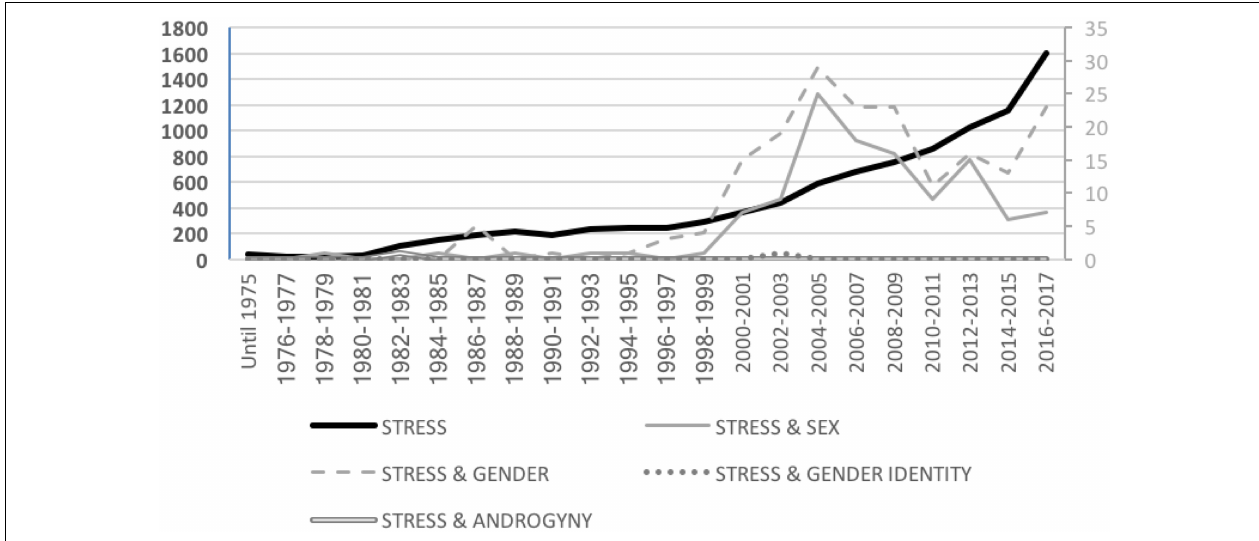
FIGURE 2 | Total number of scientific articles per year about workplace stress by gender category. Given the substantially greater number of studies examining workplace stress than studies incorporating a gender perspective, data are presented in different scales. The axis on the left side of the figure represents the total number of articles for workplace stress (without gender-related keywords), whereas the axis on the right represents the total number of articles incorporating a gender perspective in any of our four gender categories (i.e., gender, sex differences, gender identity, or androgyny). The same rationale applies to Figures 3 – 6